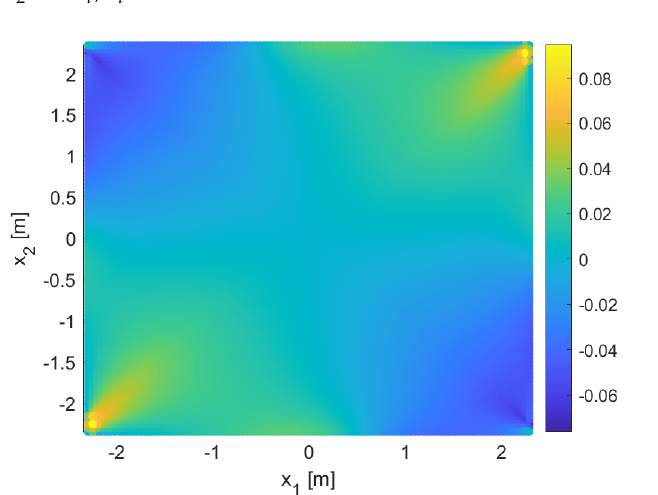
Figure 21. Effects of the change of boundary conditions on the shape of the